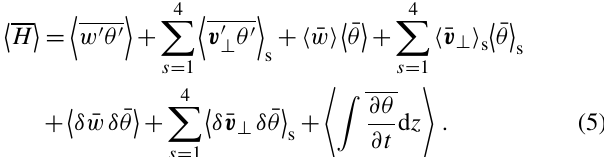
From − 53.8 to − 0.01 (average −